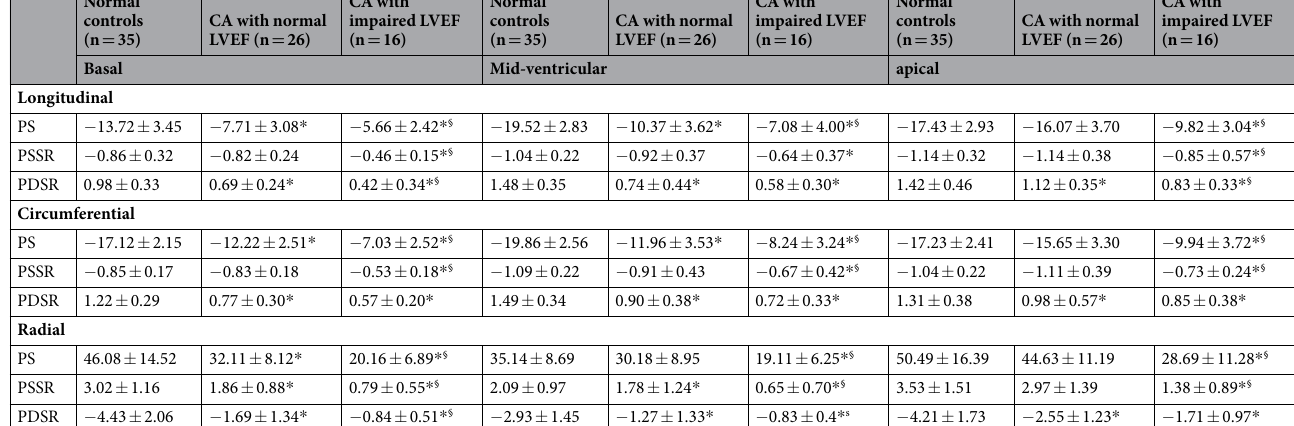
Table 4. Values for left ventricular deformation parameters obtained using feature tracking for slice values of all study groups (basal, mid, apical). Notes: The values are the mean ± SD, other abbreviations are the same as in